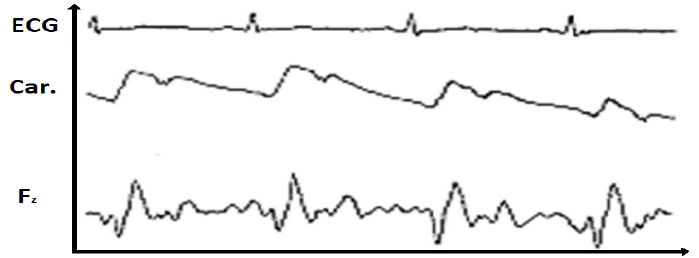
Figure 7. Effect of the positive wave (Car.) on the results of Electrocardiography and force plate measurements (adapted by Stürm et al., 1980).